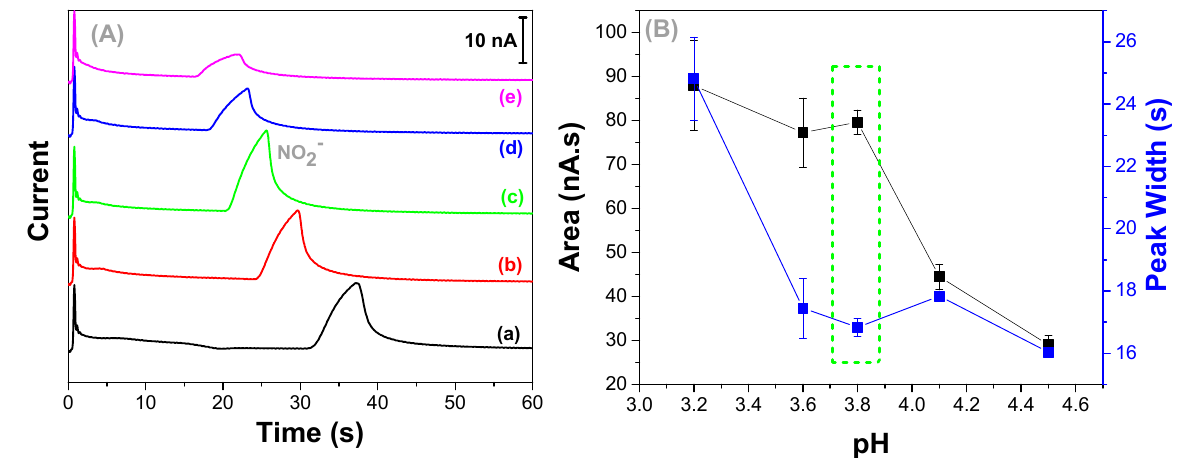
Figure 2. ( A ) Electropherograms showing the separation and detection of nitrite (50 μ mol L − 1 ) using a running buffer composed of 30 mmol L − 1 lactic acid and histidine in the concentrations between 5 and 25 mmol L − 1 , resulting in a pH from 3.2 to 4.5 (a–e). ( B ) Peak area and width versus buffer pH values. Injection: − 800 V for 10 s, Separation: − 1000 V for 60 s, Detection 0.7 V versus Pt.